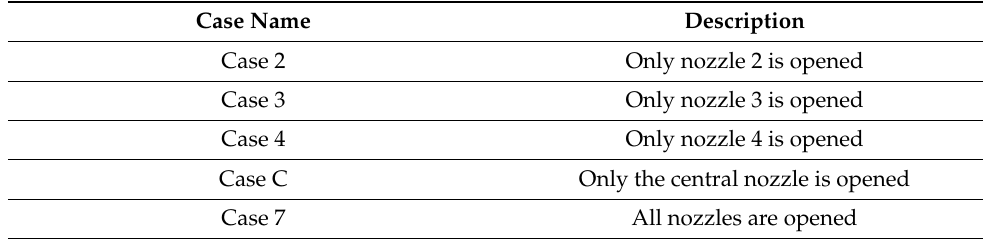
Table 2. Different cases under the partial model.